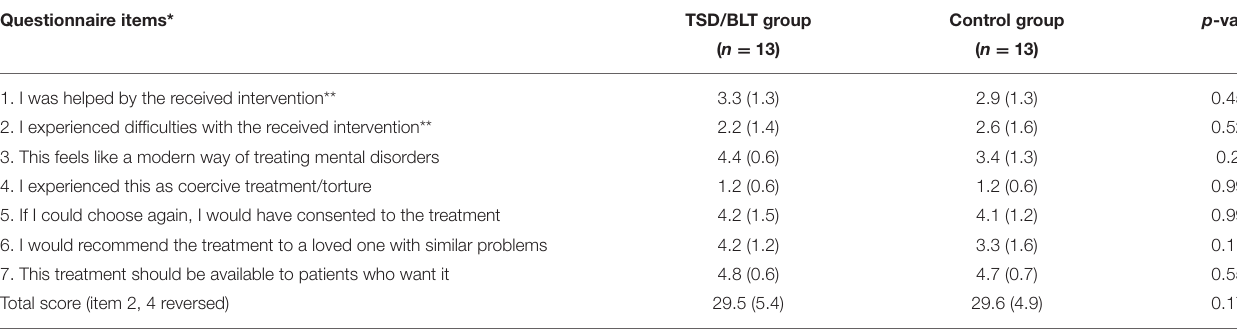
TABLE 5 | Self-report questionnaire for evaluation of acceptance of the received treatment. Questionnaire